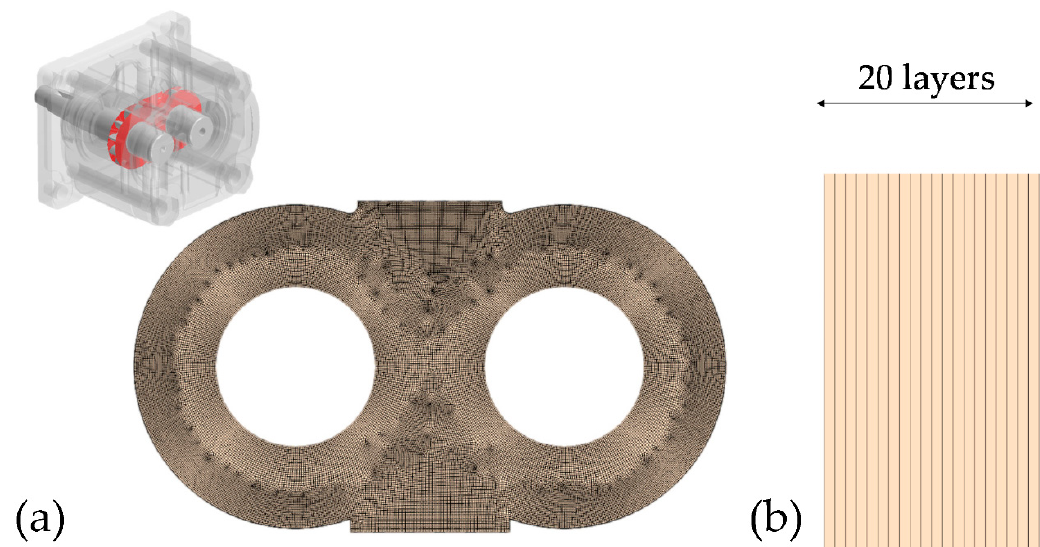
Figure 5. Overset mesh approach: ( a ) Quadrilateral mesh of the background and overset regions; ( b ) initialized overset interfaces; ( c ) zoomed view of the gears’ meshing region; ( d ) zoomed view of the mesh in the 10- μ m radial gap.